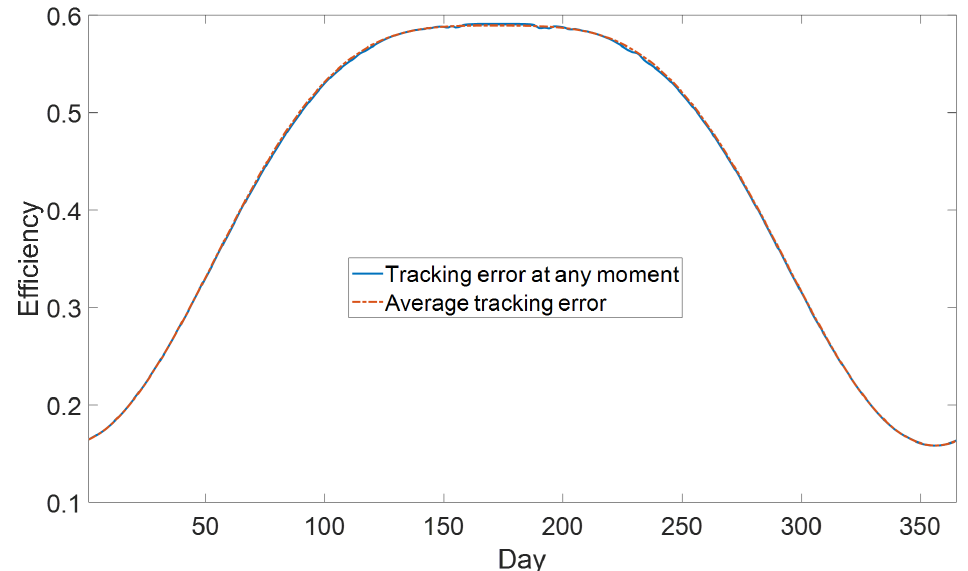
Figure 5. Efficiency comparison of two system calculated with tracking error at every moment and average tracking error, respectively, with the Bourges and Lamm method under north–south axis tracking system. Table 5. Average annual tracking error and efficiency of system with Cooper and Woolf method under three different tracking methods, efficiency calculated with average tracking error and the relative difference between two